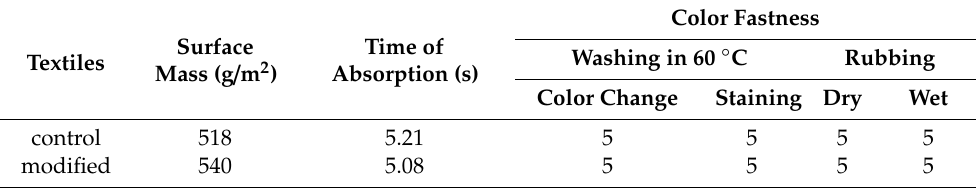
Table 2. Selected properties and color fastness of terry cotton fabrics.